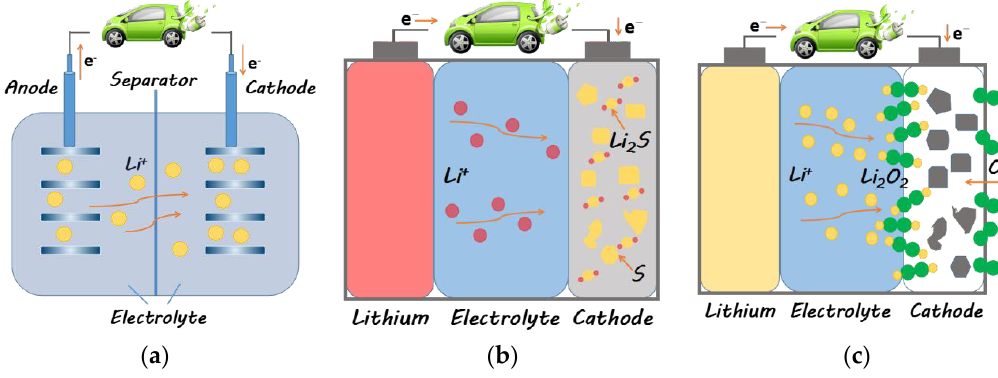
Figure 2. Schematics of: ( a ) Li-ion batteries; ( b ) lithium-sulfur batteries; ( c ) lithium-oxygen batteries.